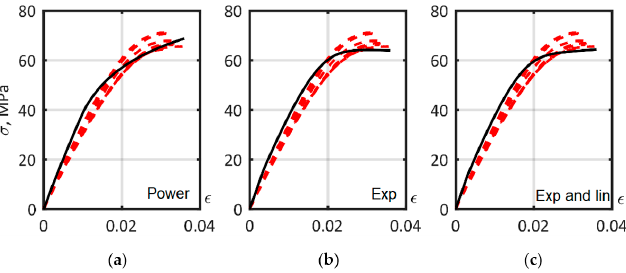
Figure 17. Matrix models (solid lines) after the composite stiffness calibration with different hardening laws: ( a ) power; ( b ) exponential; ( c ) exponential and linear. Dashed lines—experiment. Table 6. Failure criteria strain limits for different fiber mass fraction cases.